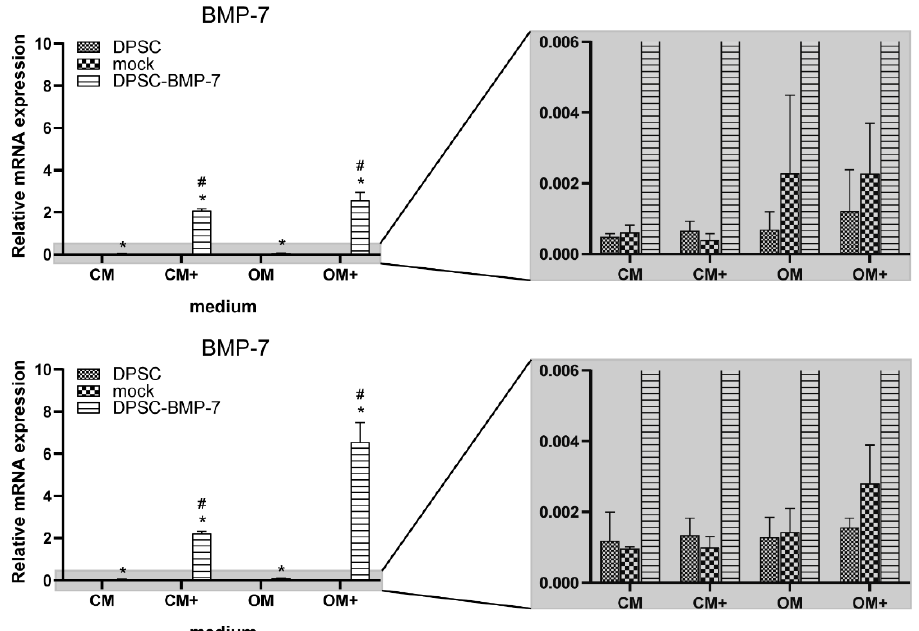
Figure 2. The expression level of BMP-7 mRNA in the case of the indicated cell lines. After 1 week (above) and 3 weeks (below) of induction in different media (mean ± SD; n = 3). *, p < 0.05 vs. control in the same media, #, p ˂ 0.05 vs. untreated (CM or OM respectively) group of the same cell line.